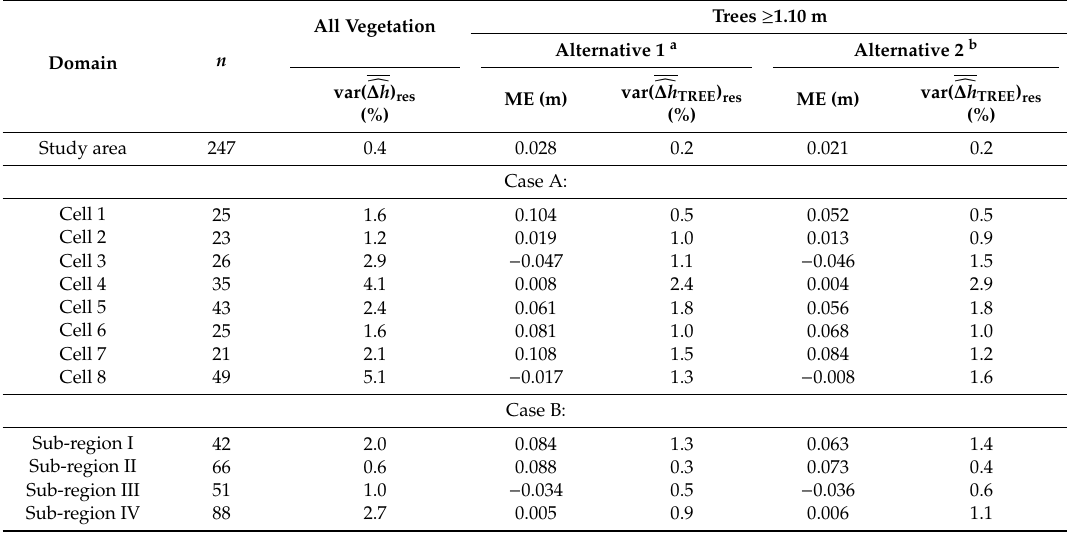
Table 5. Contribution of the residual variance component to overall mean square error of estimates of change in vegetation height (var and mean error (ME) estimated according to e.g.